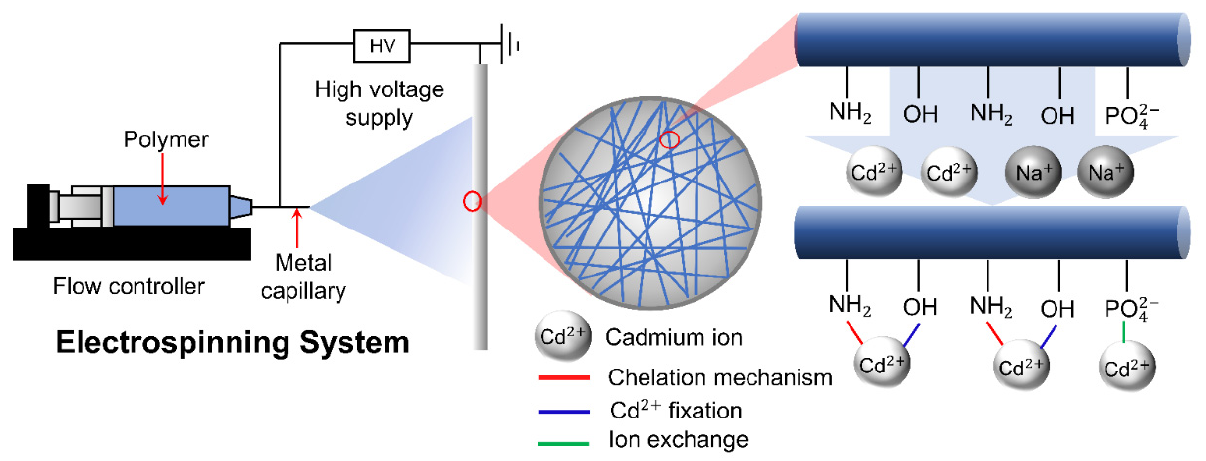
Figure 10. Setup of electrospinning system and mechanism of Cd 2+ adsorption on the chitosan/PNC membrane.